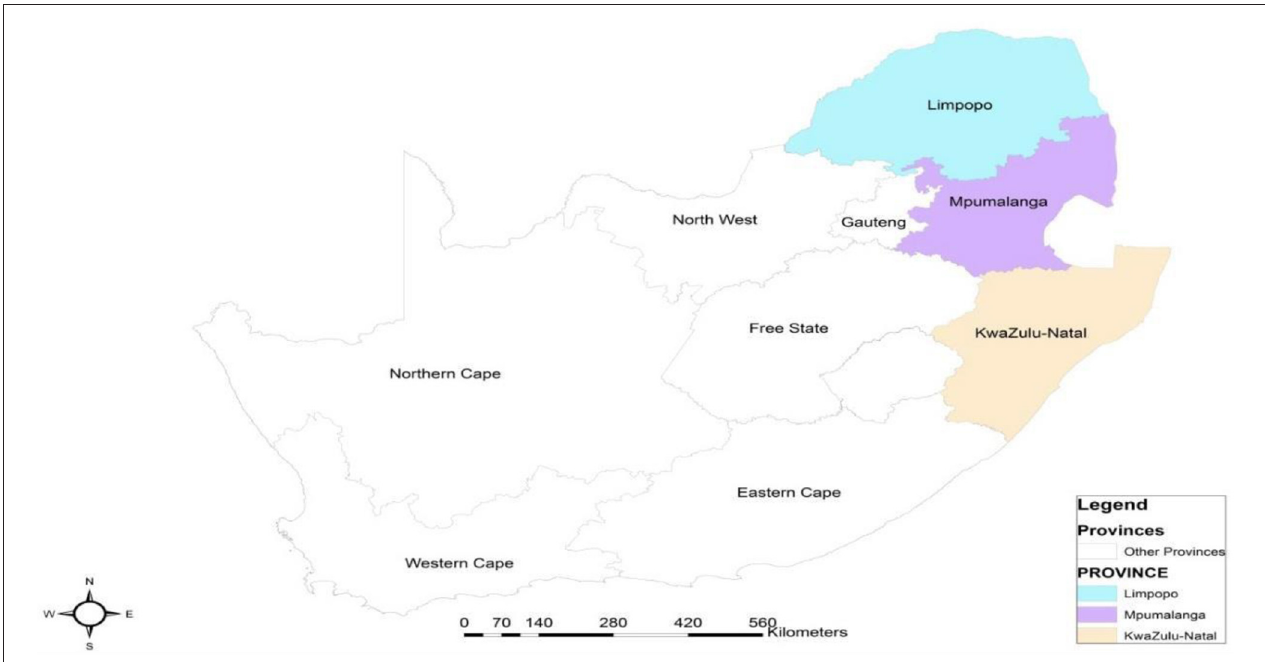
FIGURE 1 | Map of the Republic of South Africa showing the study